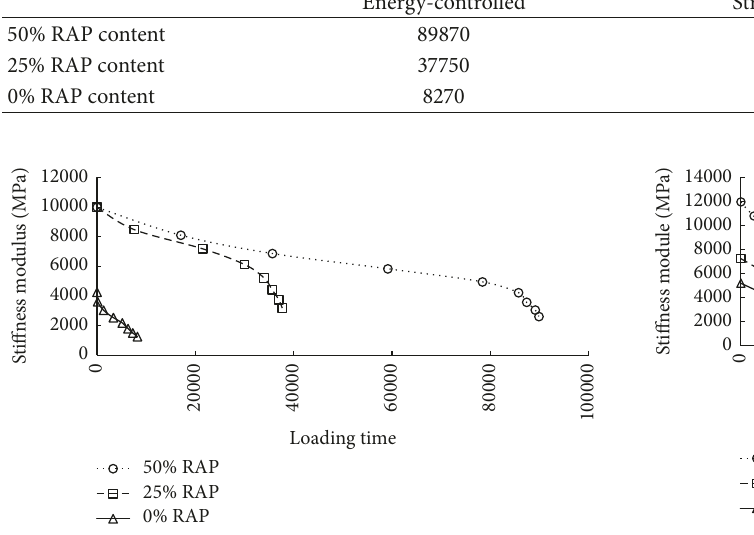
Figure 6: Flexural stiffness variation under the strain-controlled mode at 15 ∘